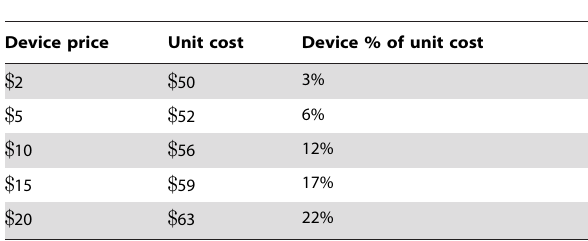
Table 4. Sensitivity analysis of device price on unit cost at mixed study site with 68% of circumcisions conducted using the PrePex